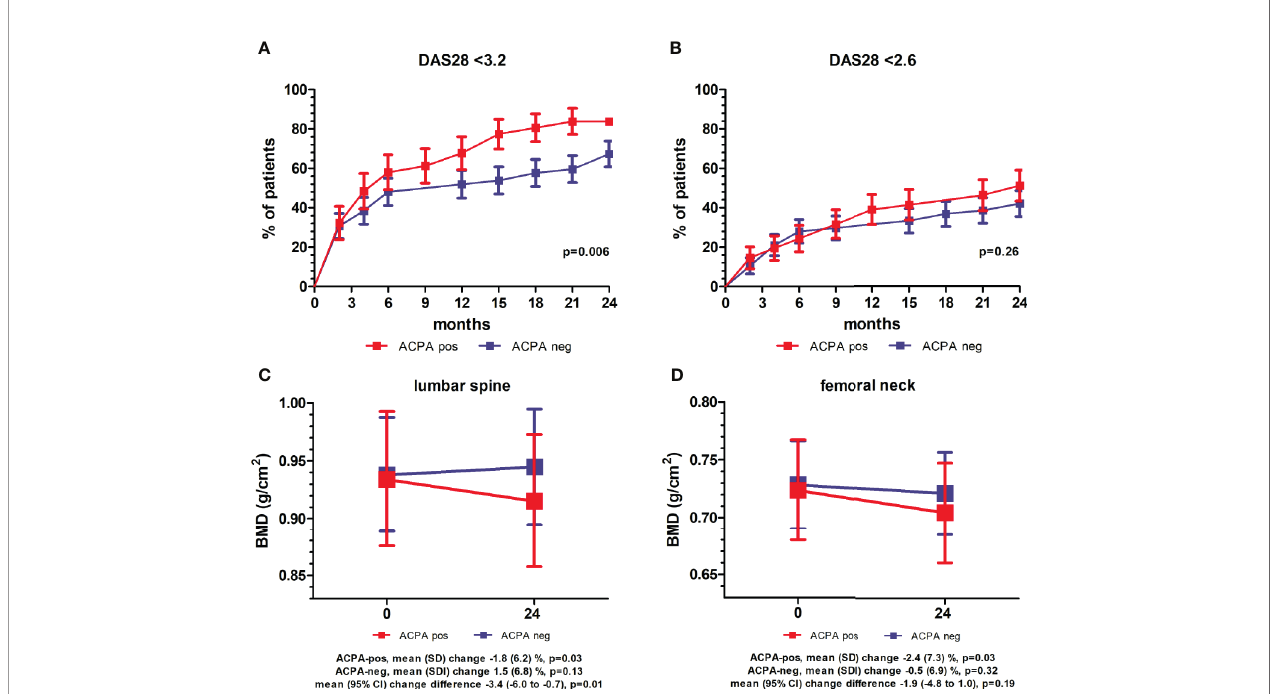
FIGURE 1 | Clinical and densitometric follow-up strati fi ed for anti-citrullinated protein antibodies. (A, B) Percentage of patients (± standard error) achieving low disease activity (LDA, DAS28 <3.2) (A) and remission (DAS28 <2.6) (B) over 24 months of follow-up strati fi ed for anti-citrullinated protein antibodies (ACPA). p values refer to unadjusted Cox proportional-hazards regression. (C, D) Mean (95% con fi dence interval, CI) bone mineral density (BMD) at the lumbar spine (C) and femoral neck (D) at baseline and after 24 months in ACPA-positive and -negative patients. p values refer to pairwise comparisons between baseline and follow-up within ACPA-positive and – negative patients (paired samples t-test), and comparison of mean changes between ACPA-positive and – negative patients (independent samples